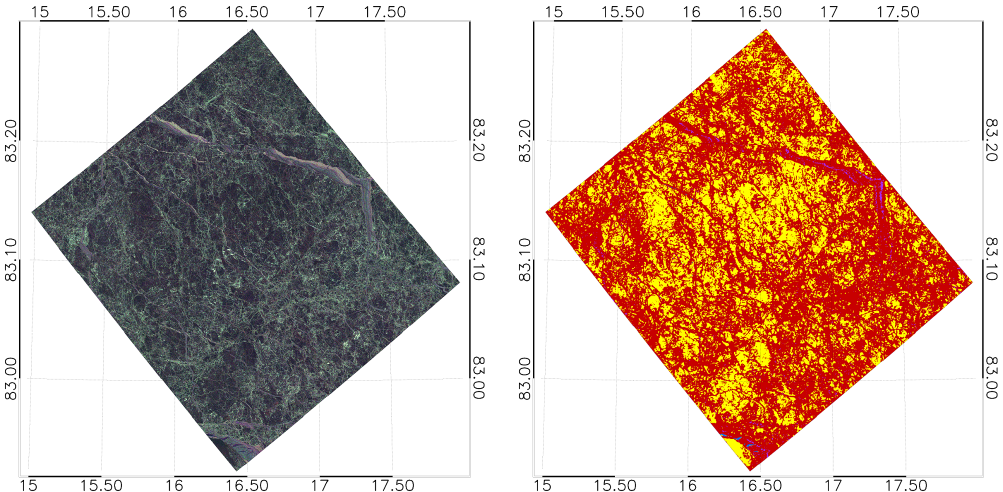
Figure 8. ( Left ) Geocoded Pauli RGB composite (Red: HH-VV Green: HV+VH Blue: HH+VV) of the RS-2 acquisition on 23 April 2015, frame 1; ( Right ) ice classification. Blue: open water/nilas (OW), purple: young ice (YI), yellow: first year ice (SFYI), red: rough first year ice/multi-year ice